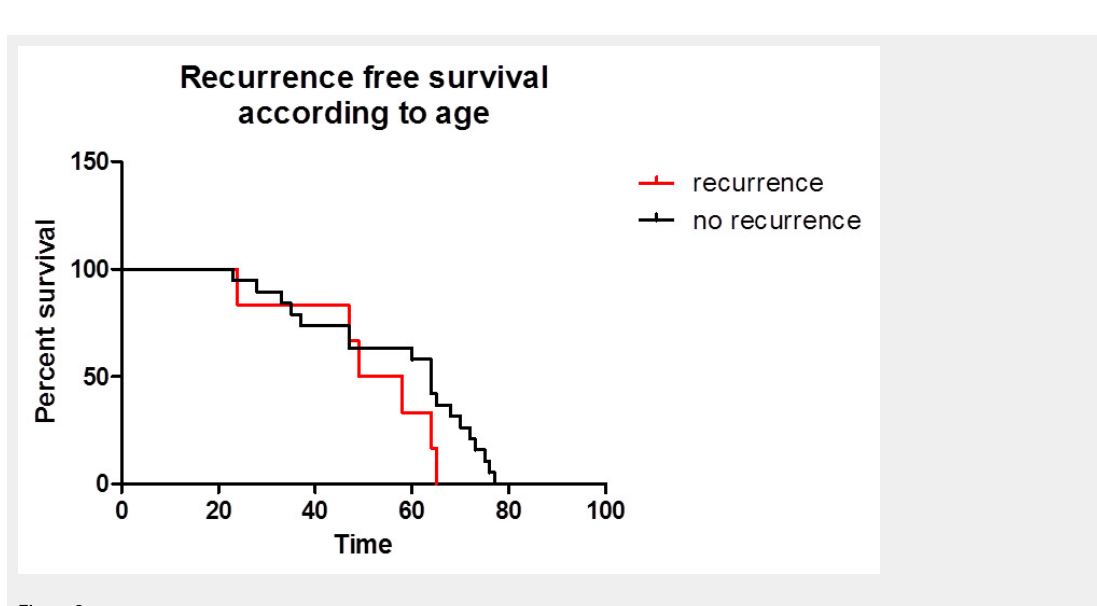
Figure 2 Kaplan-Meier curve showing age and recurrence free